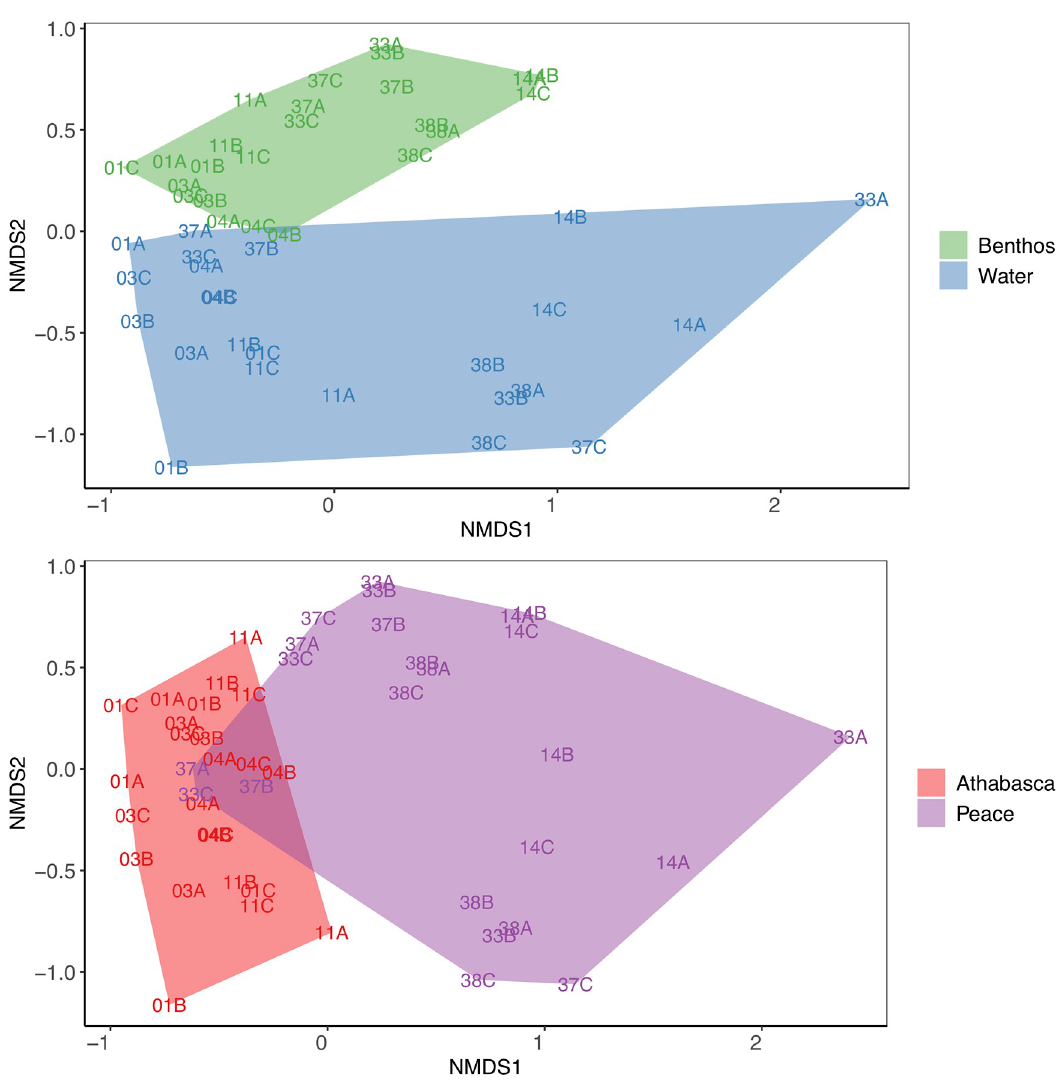
Fig 4. Samples cluster by collection method and river delta. The NMDS is based on rarefied data and Sorensen dissimilarities based on presence-absence data. The first plot shows sites clustered by collection method, benthos or water. The second plot shows sites clustered by river delta, Athabasca River or Peace River